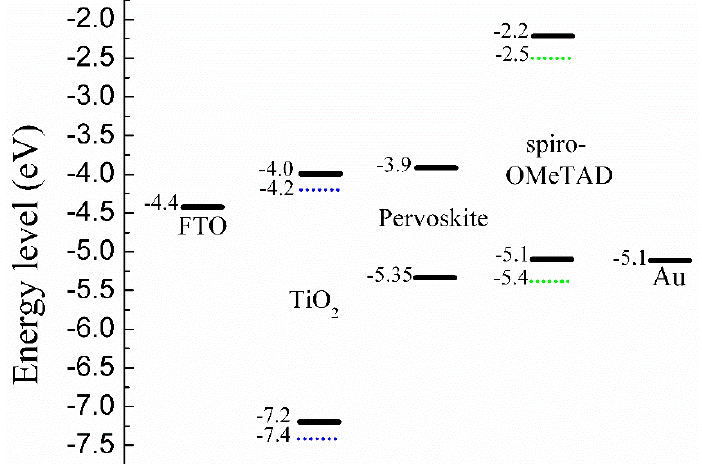
Figure 8. Energy-level diagram of the perovskite solar cell.